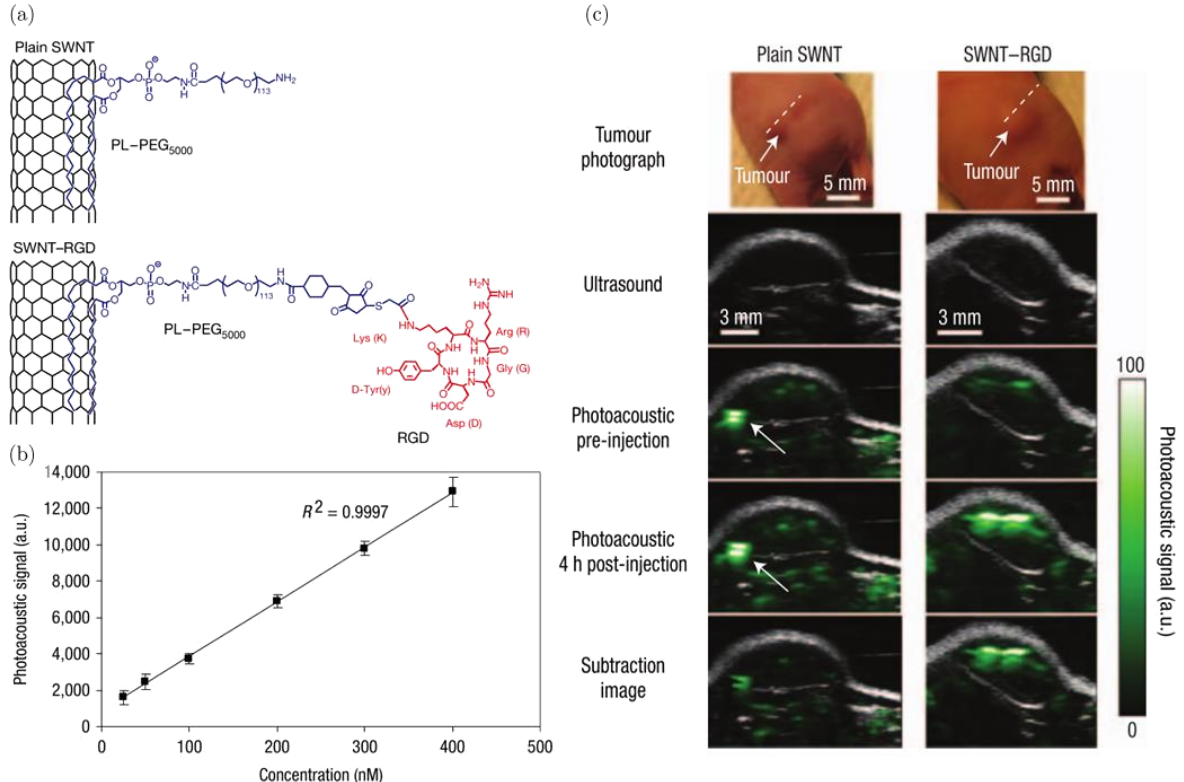
Fig. 4. (a) Schematic illustration of SWNTs conjugated with RGD peptides for targeted PAT of mouse tumor. (b) The PA signal produced by single-walled carbon nanotubes was observed to be linearly dependent on the concentration ( R 2 ¼ 0 : 9997). (c) B-scan US and PAIs of U87MG tumor acquired along a white dotted line aided by SWNTs. The ultrasound images (gray) show the skin and tumor boundaries, whereas PAT images (green) show optical absorption (SWNT – RGD) in the tumor. Di®erential images were obtained by subtraction of the pre-injection image from the 4 h post-injection